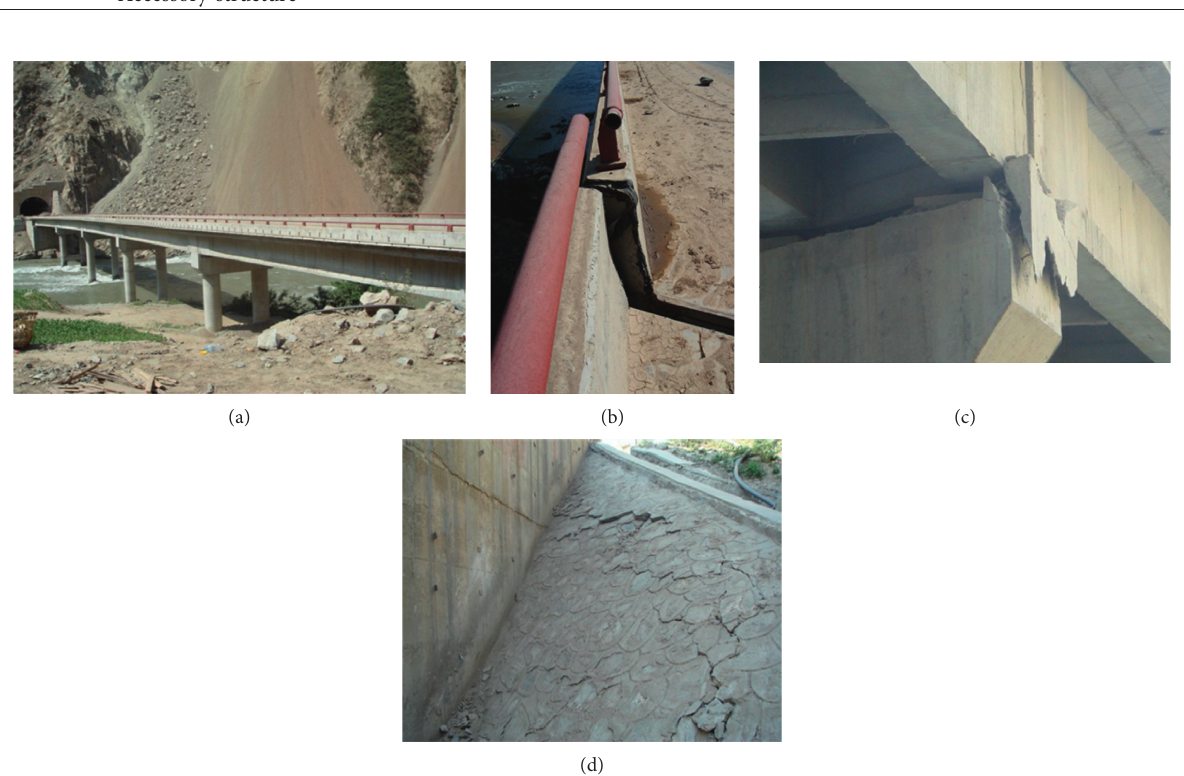
Figure 1: The damage pictures of the Caopo 3 rd bridge (seriously damaged; the bridge length is 225